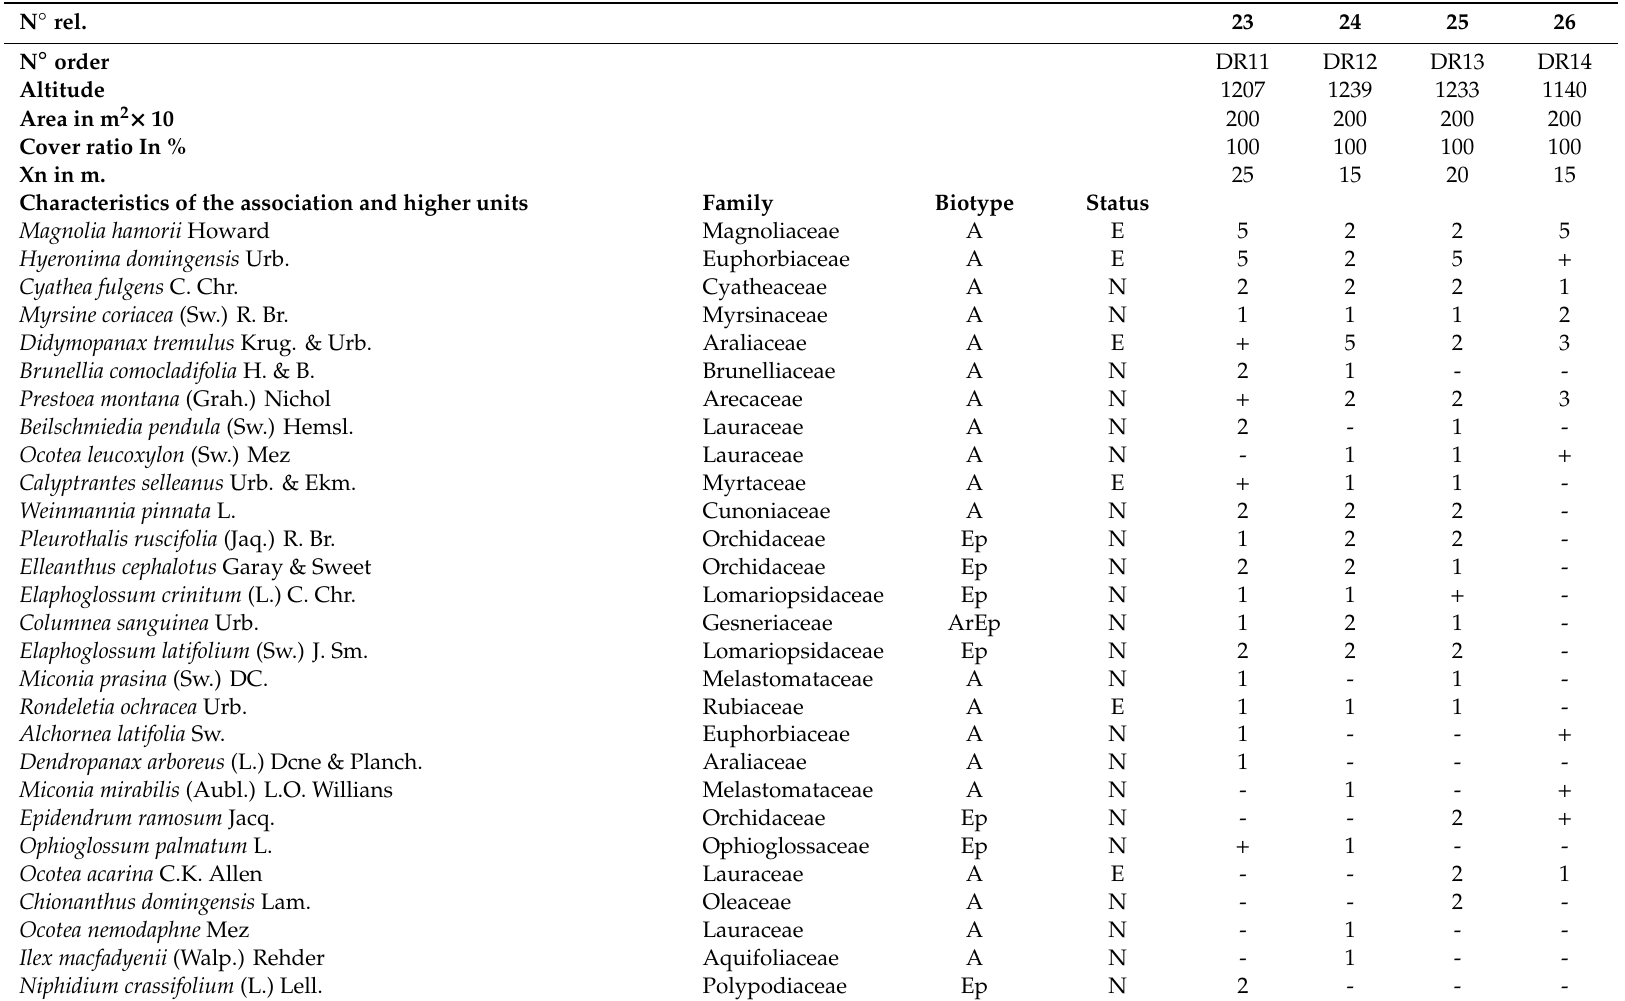
Table A3. Association Hyeronimo dominguensis-Magnolietum hamorii.